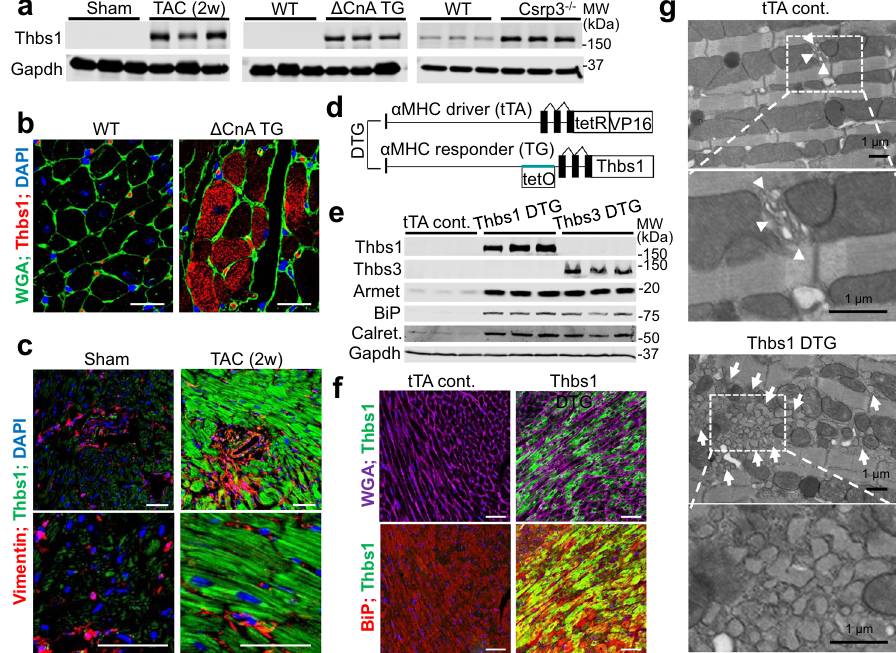
Fig. 1 Expression of Thbs1 is induced in diseased hearts where it mediates ER stress. a Western blotting for Thbs1 in heart tissue of mice (8 – 10 weeks of age) subjected to 2 weeks of TAC, that contained the activated calcineurin A transgene ( Δ CnA), or are Csrp3 − / − , compared to sham-operated or wild-type (WT) control. Gapdh is shown as a processing and loading control. b Representative immunohistochemistry for endogenous Thbs1 (red) and cell outlines with wheat germ agglutinin (WGA)-FITC (green) with DAPI-stained nuclei (blue) from hypertrophic Δ CnA transgenic and WT control hearts at 8 weeks of age. Scale bars are 10 μ m. c Immunohistochemistry for Thbs1 protein (green), vimentin (red) from sham or TAC-operated hearts, 2 weeks later. Scale bars are 50 μ m. Nuclei are shown in blue with DAPI. d Schematic diagram depicting the inducible double transgenic (DTG) tetracycline-repressor system for inducible overexpression of Thbs1 in the heart. e Representative Western blots for Thbs1, Thbs3, Armet, BiP, calreticulin (calret.), and Gapdh as a loading control from hearts of tTA cont., Thbs1 DTG, and Thbs3 DTG mice at 6 weeks of age. f Representative immunohistochemistry broken into 2 channels each for overexpressed Thbs1 (green) with WGA-labeled membranes (purple), DAPI for nuclei (blue) and BiP (red) to show ER and the vesicular compartment in Thbs1 DTG hearts at 8 weeks of age. Scale bars are 50 μ m. g Representative images of transmission electron microscopy of heart sections from tTA cont. and Thbs1 DTG mice at 6 weeks of age. Upper panels: arrowheads indicate ER in tTA cont., white arrows show expanded ER and vesicles only in Thbs1 DTG hearts. Lower panels: enlargement of white dotted boxed area from upper panels. Scale bars are 1 μ m. Source data are provided as a Source Data